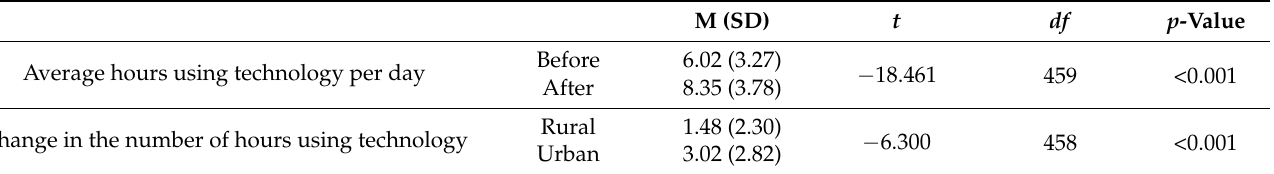
Table 1. Number of hours using technology per